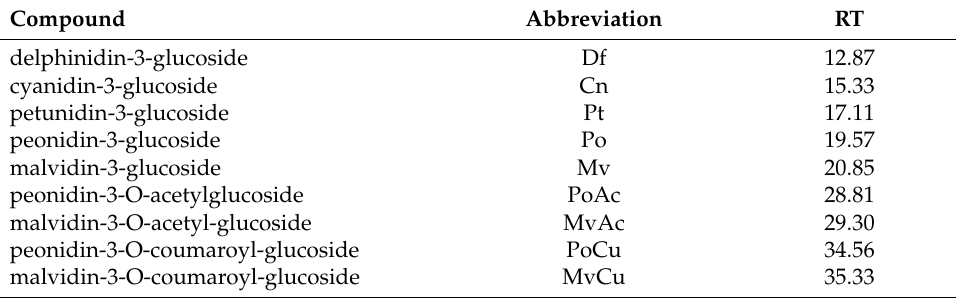
Table 2. Grape anthocyanin pigments with approximate HPLC retention